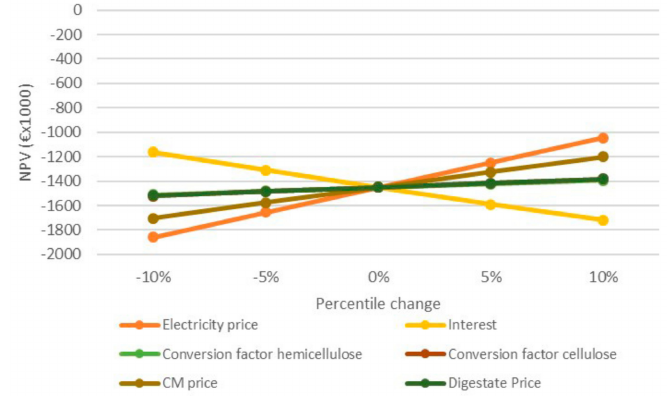
Figure 5. Impact of ± 5% and ± 10% change of the parameters on the profitability of a biogas power plant that uses CM as